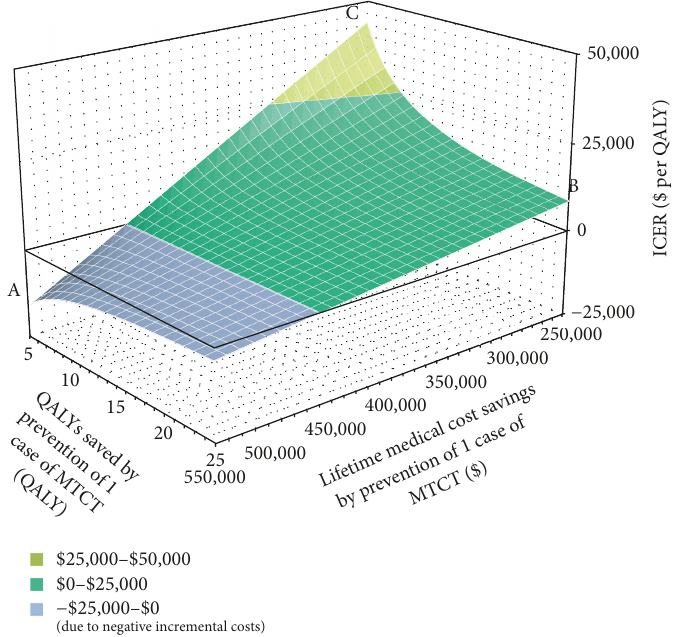
Figure 3: Two-way sensitivity analysis: impact of QALY saved per prevented case of MTCT and lifetime medical costs of PAH on ICER (universal screening relative to standard of care in the DC